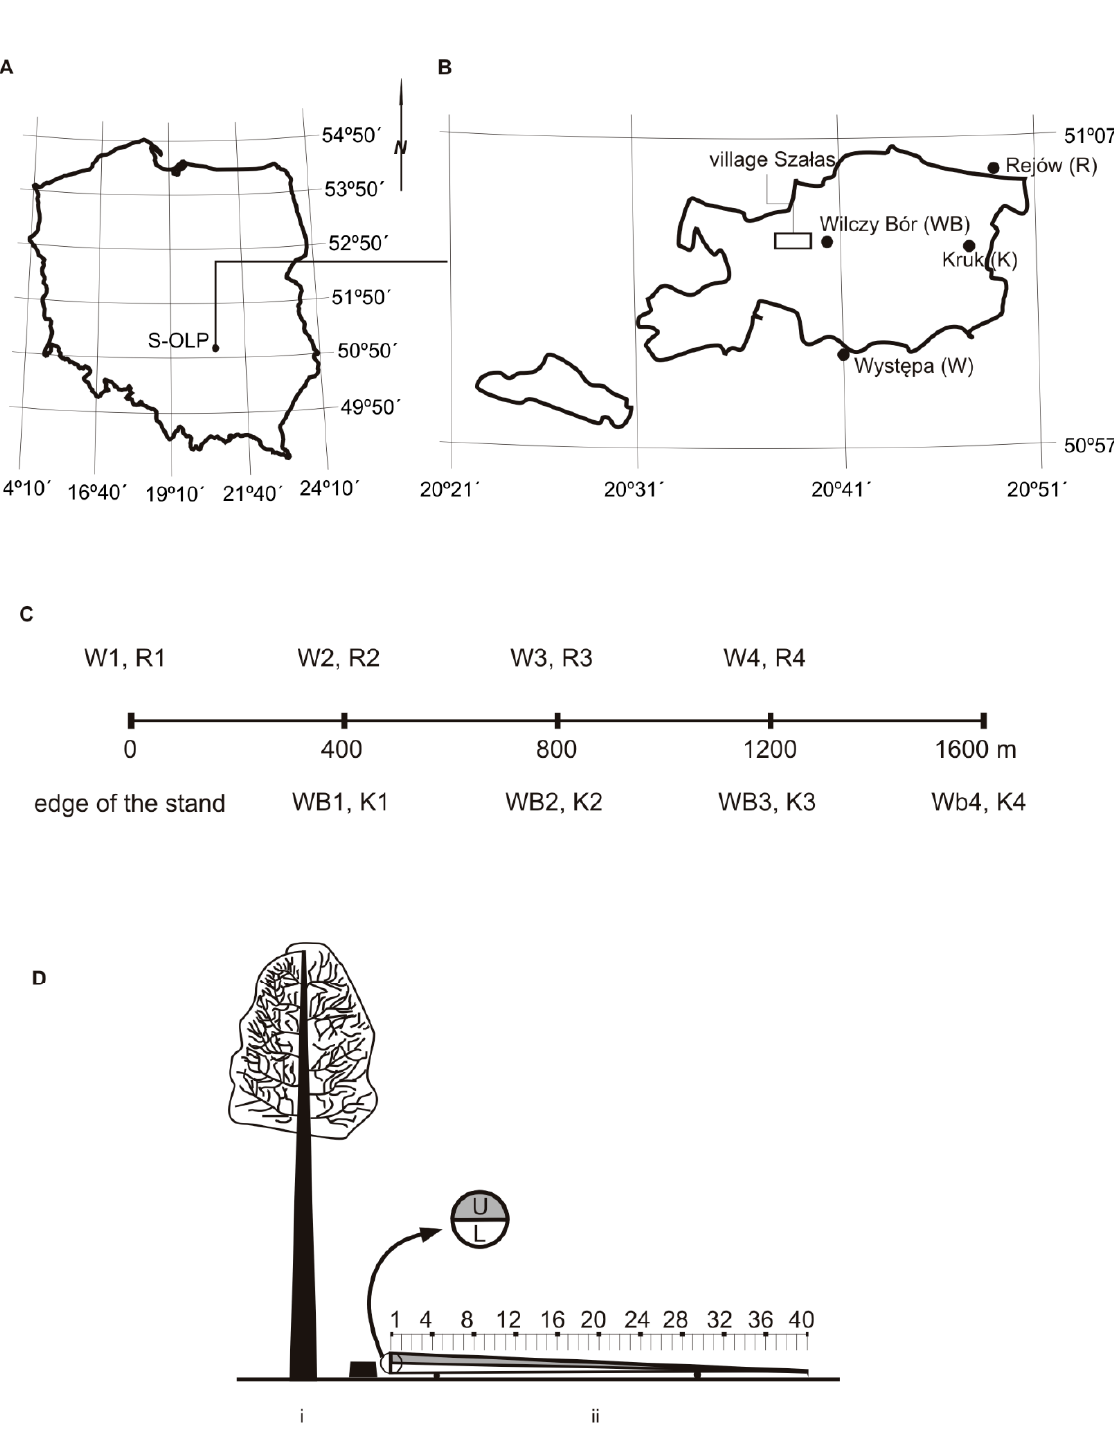
Figure 1. Study region. ( A ) Grid of the SINUS (System of Information on Natural Environment) system for Poland; S-OLP—Suchedniowsko-Obl ę gorski Landscape Park ( B ) location of Forest sub- district ( C ) location of sample plots in respective distance zones; W1-4, R1-4, WB1-4 and K1-4 for plot codes—see Table 1 ( D ) Healthy pine (i) used as a trap tree (ii); letters U and L indicate the upper and lower section of the trap tree, respectively. Numbers 1, 2, ..., and 40 indicate stem units.